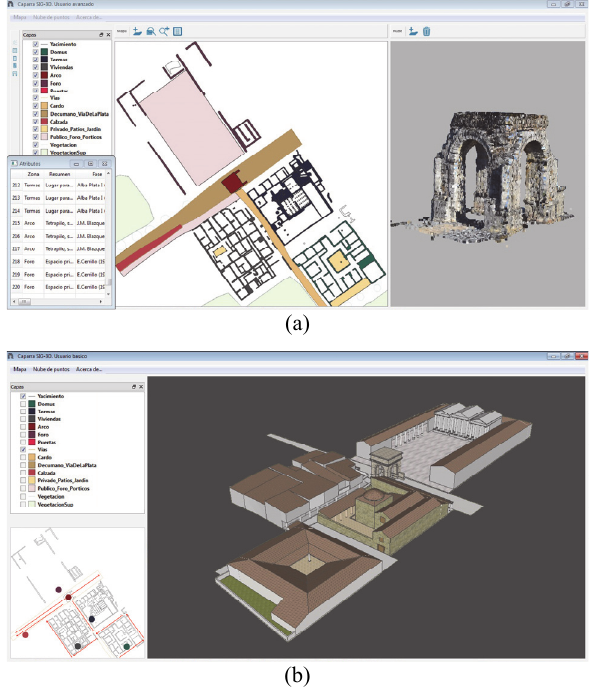
Figure 10. Different user interfaces of hybrid viewer according to the user profile: (a) advanced and (b) basic.